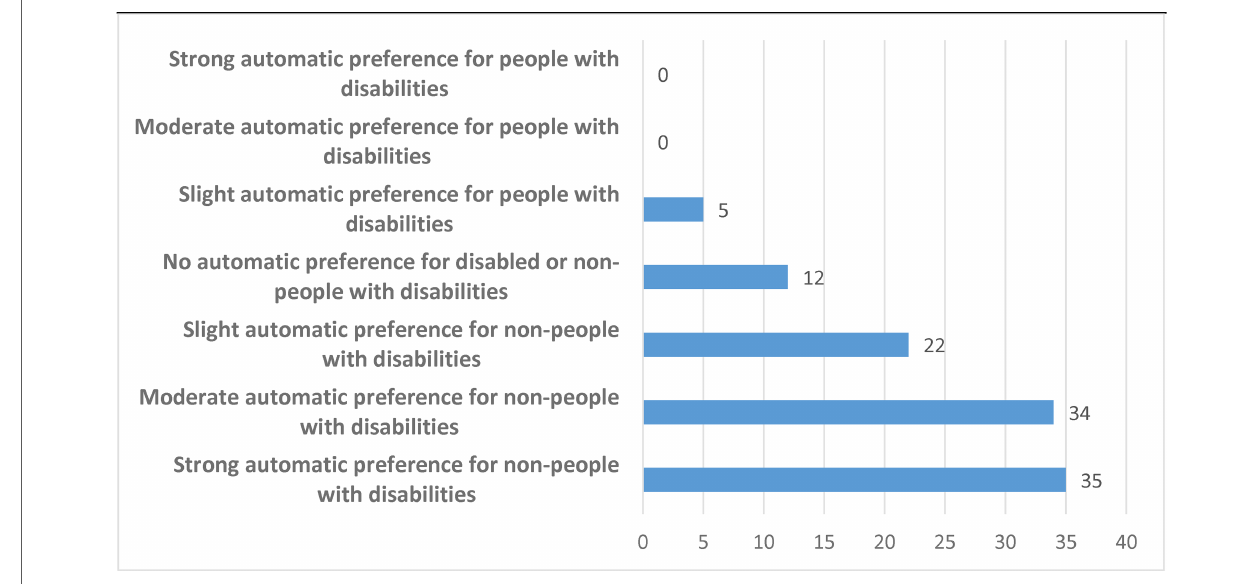
FIGURE 2 Distribution of disability IAT scores ( N =108).